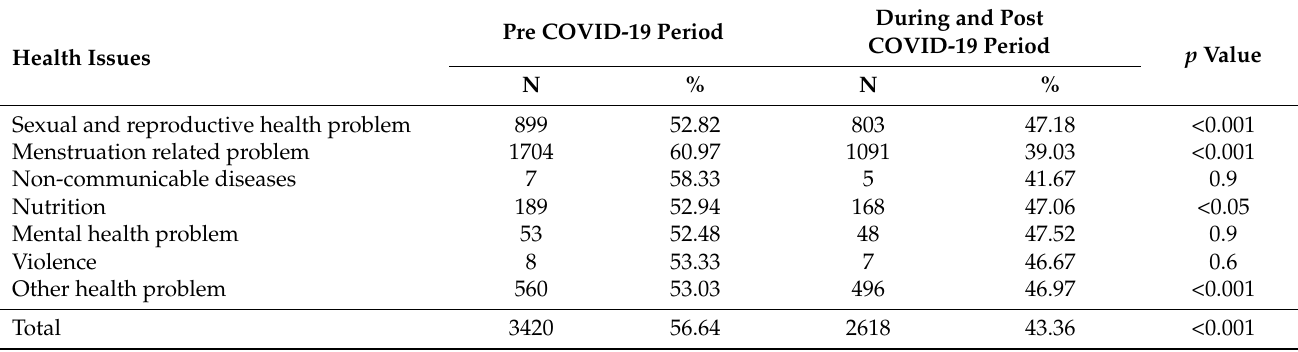
Table 6. Comparison of prevalence of beneficiary functionality during and after the COVID-19 epidemic ( n =